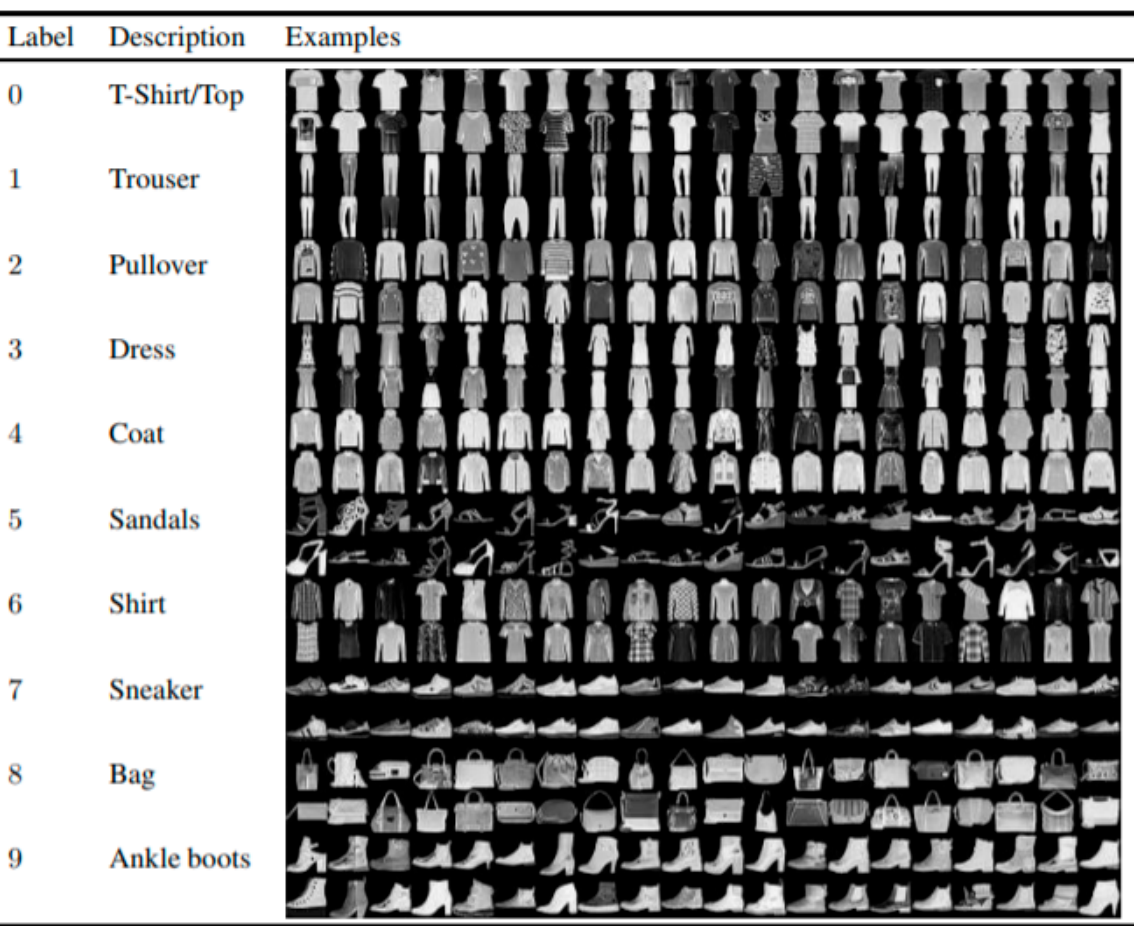
Figure 9. Fashion MNIST class labels and examples from [40].